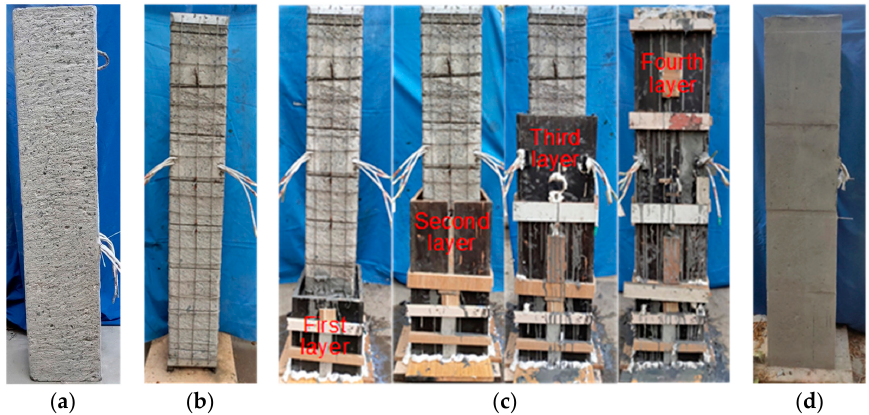
Figure 3. Reinforcement process. It is divided into four steps, followed by: ( a ) chiseling; ( b ) binding; ( c ) casting; ( d )